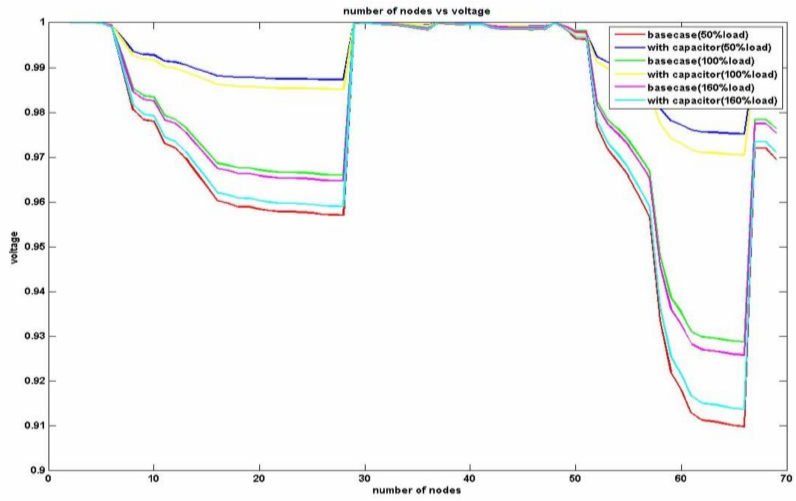
Figure 5. Voltage magnitude vs. the number of nodes with and without the capacitor.